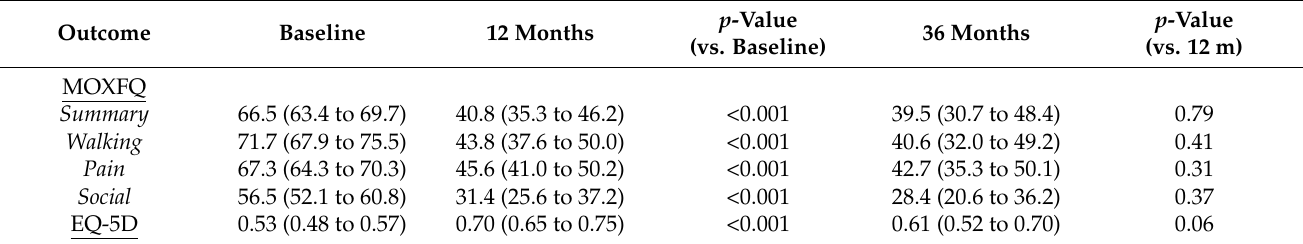
Table 4. Mean outcomes following BMC for